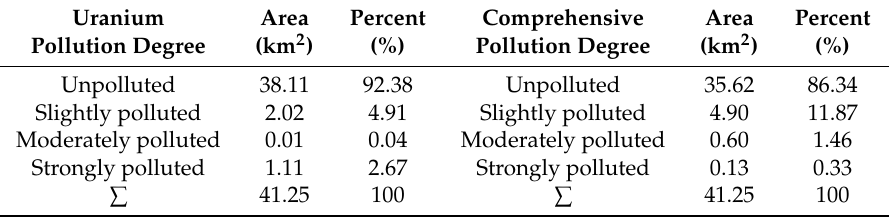
Table 6. The areas and percent of uranium pollution degree and comprehensive pollution degree.